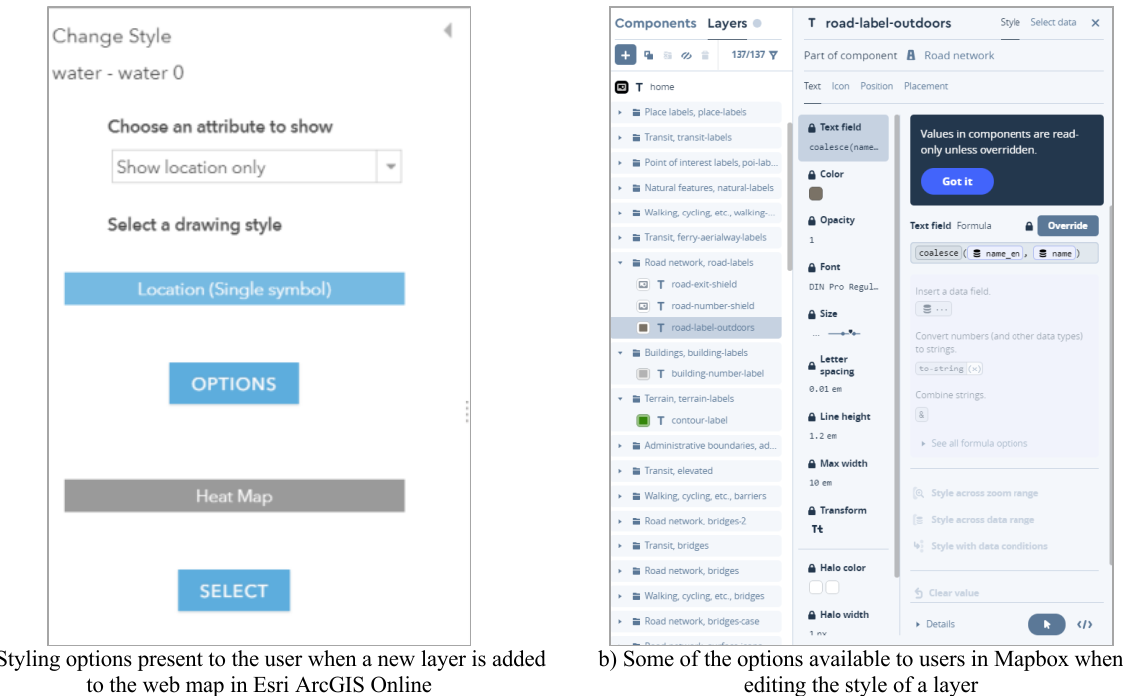
Figure 1. User interface presented to the user for styling when adding a new layer to the web